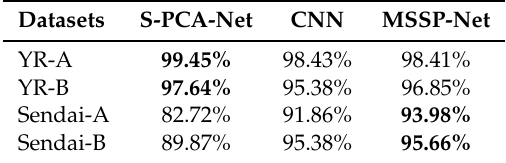
Table 3. The cross-dataset change detection accuracies of compared